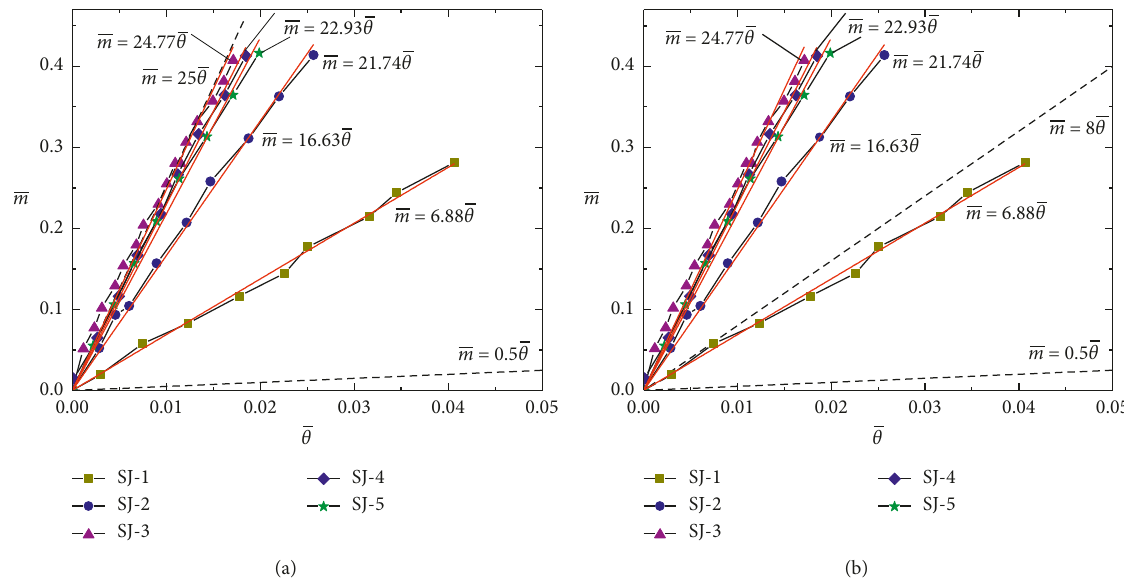
Figure 12: Connection classification by initial stiffness. (a) Nonbracing frame. (b) Bracing